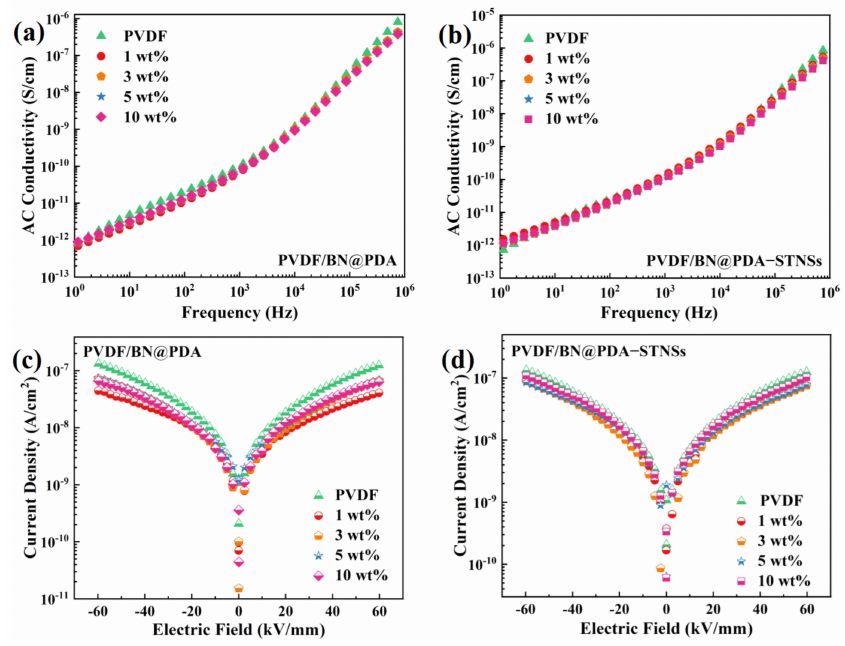
Figure 6. The AC conductivity of ( a ) PVDF/BN@PDA and ( b ) PVDF/BN@PDA − STNSs composites. The current density at 60 kV/mm of ( c ) PVDF/BN@PDA and ( d ) PVDF/BN@PDA − STNSs